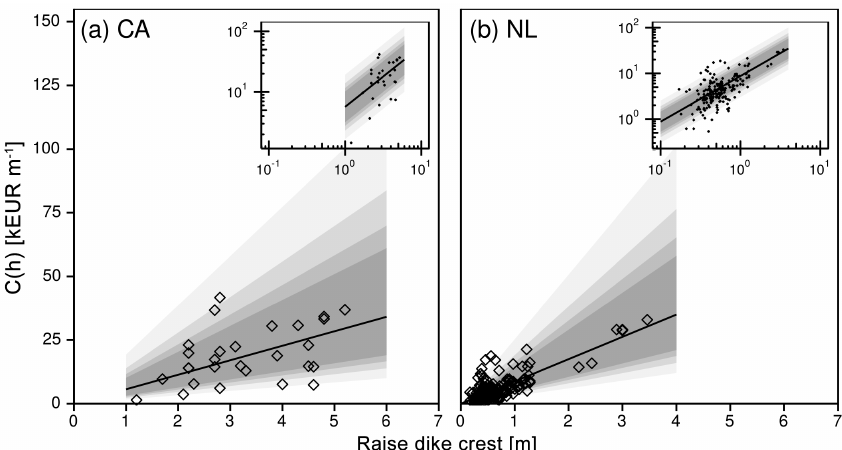
Figure 2. Spread of dike costs and estimated uncertainty. The dike costs are shown together with the linear regressions without intercept, Eq. (1), and with quantiles of estimated log-normal distributions. (a) Canadian dikes and (b) dikes in the Netherlands. The insets show the same items but in double logarithmic scale. The shades give the uncertainty inclosing estimated 95, 85, 75, and 65% of the values (from light to dark).